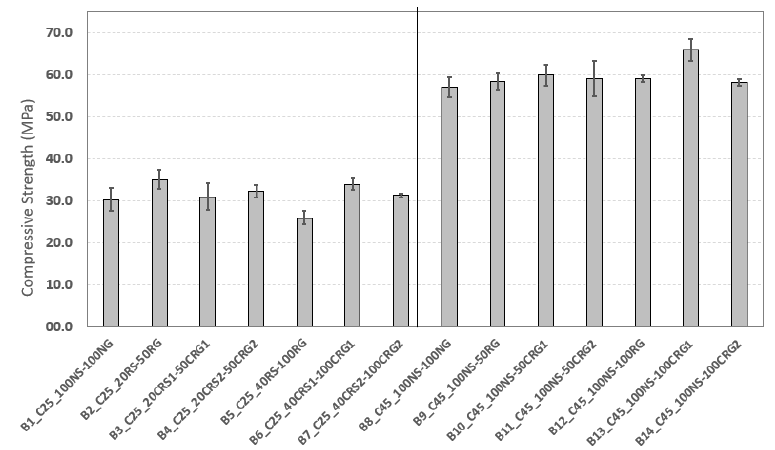
Figure 8. Compressive strength measurements of the 14